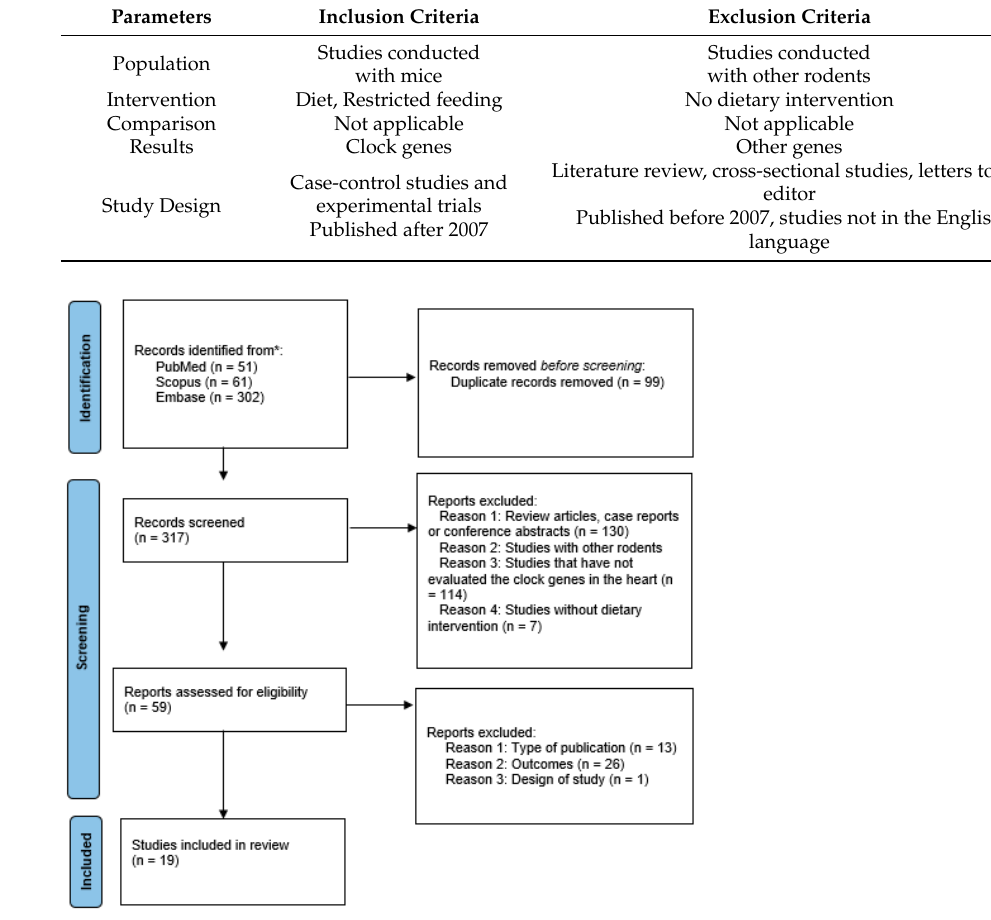
Figure 1. Flow diagram with search strategy .